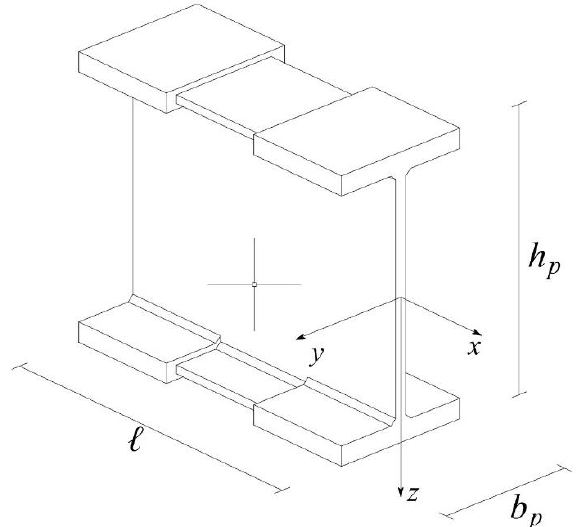
Figure 2. Device scheme.